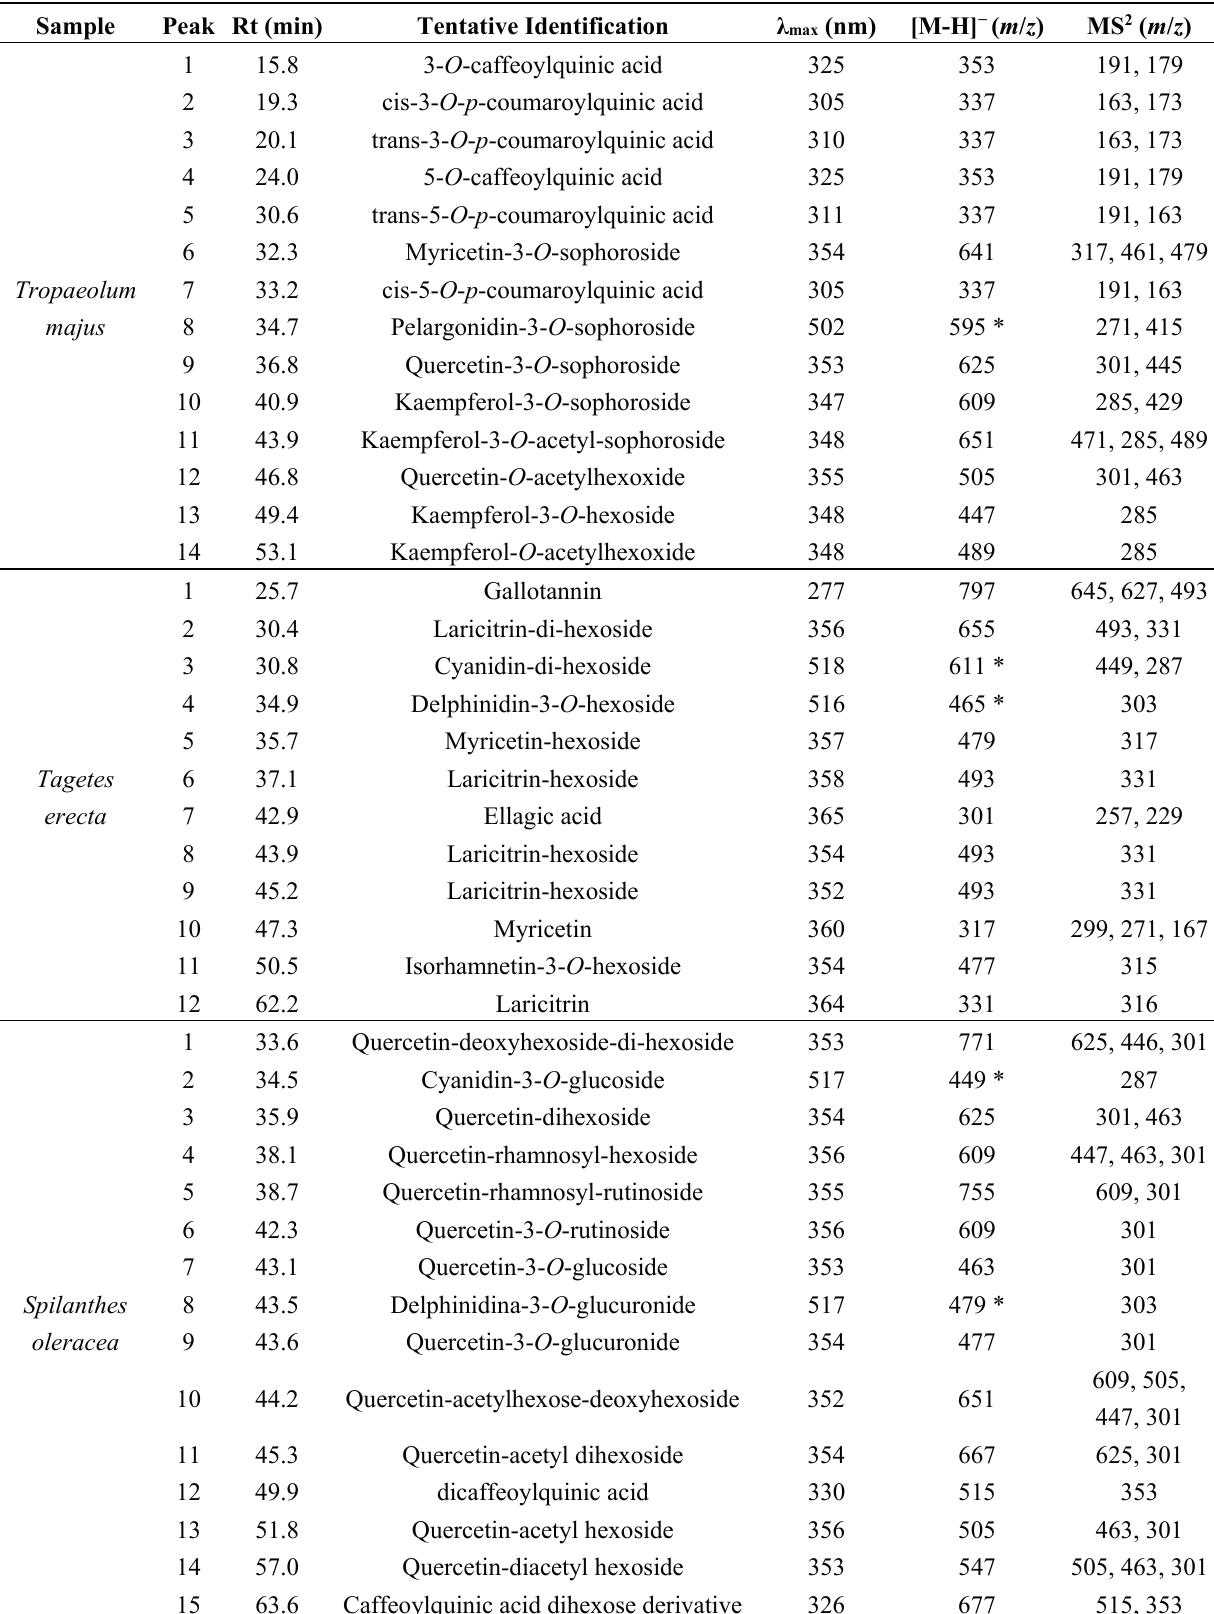
Table 4. HPLC-DAD-ESI/MS n analysis of phenolic compounds detected in edible flowers ( T. majus , T. erecta and S. oleracea ). Retention times (Rt), wavelengths of maximum absorption ( λ max ) and mass spectra. * identification in positive